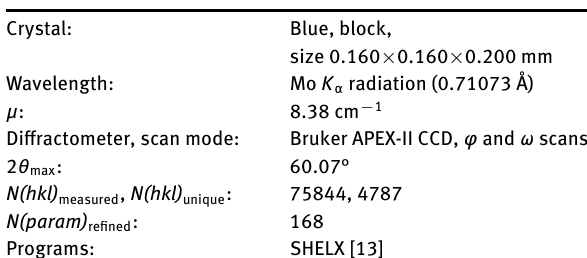
Table 1: Data collection and handling.